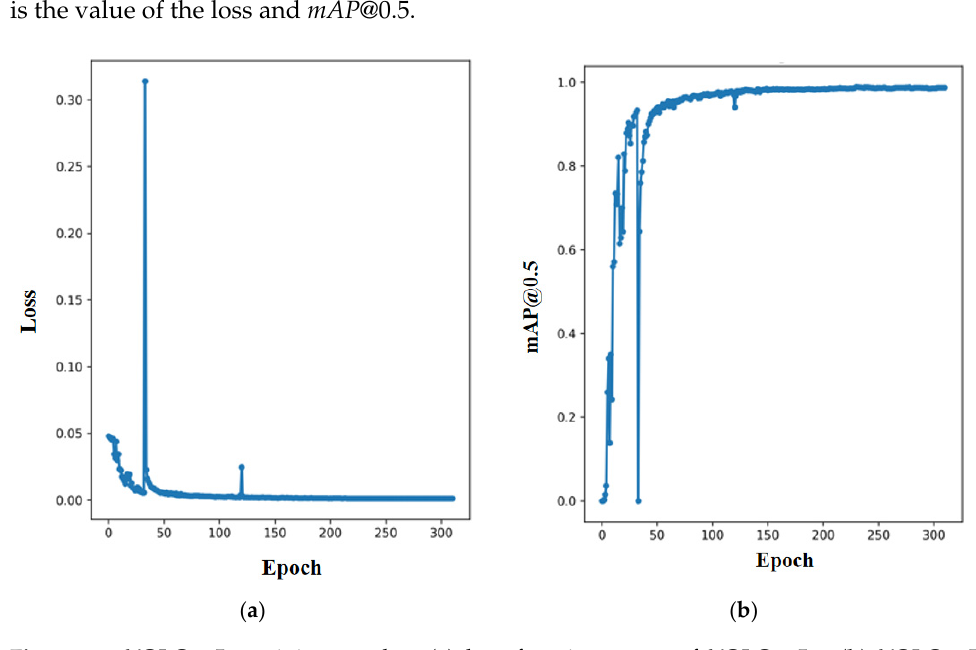
Figure 8. YOLO v5x training results: ( a ) loss function curve of YOLO v5x; ( b ) YOLO v5x mAP@0.5 curve. mAP @0.5